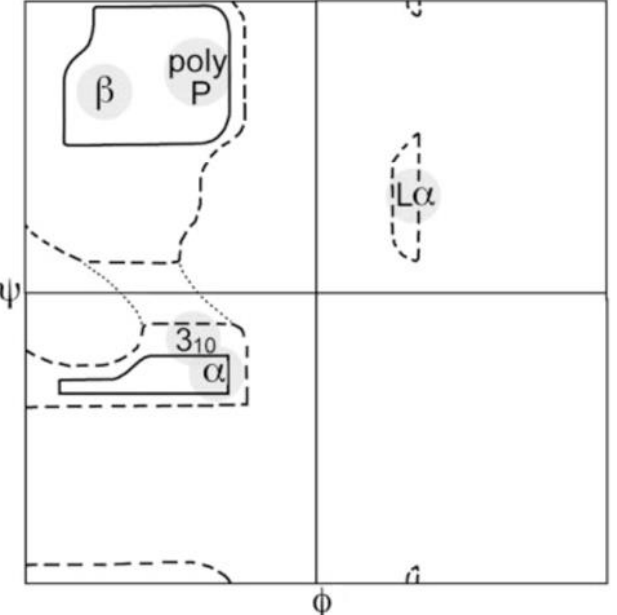
Figure 1. Sterically allowed φ, ψ space proposed by Ramachandran. Solid lines enclose the region allowed by hard-sphere bumps at standard radii; dashed lines show the region allowed with reduced radii; dotted lines add regions allowed if τ (N-C α -C′) is relaxed slightly. Ψ and φ values run from −180° to 180°. Taken from [29].